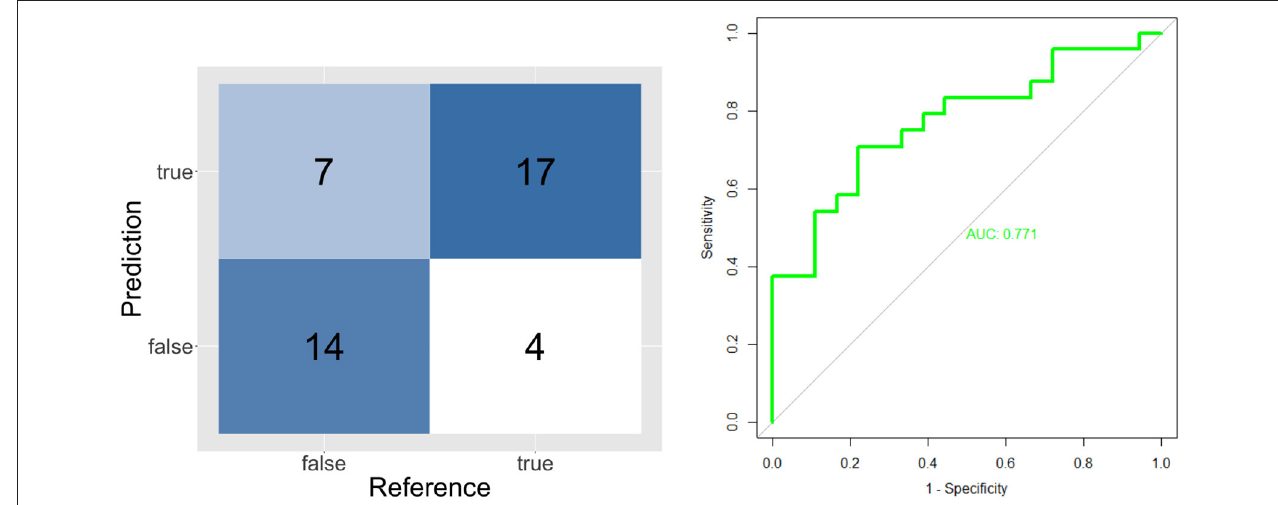
FIGURE 6 | Confusion matrix and ROC curve for long unknown message’s model (LT and LF).